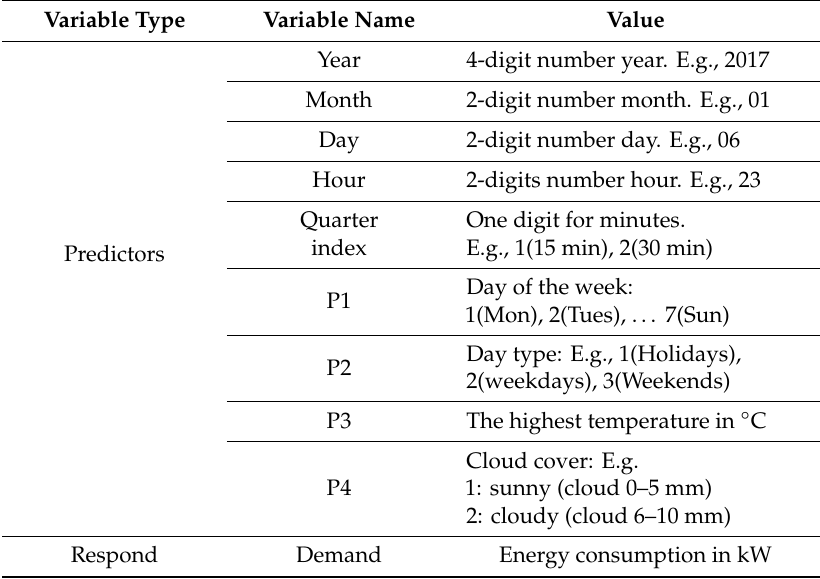
Table 1. Features